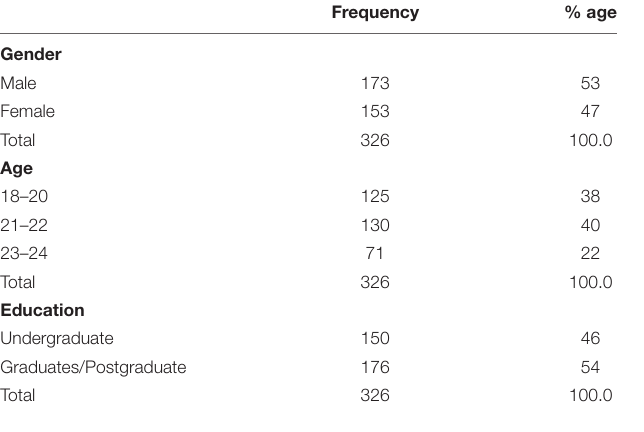
TABLE 1 | The demographic characteristics of the sample.